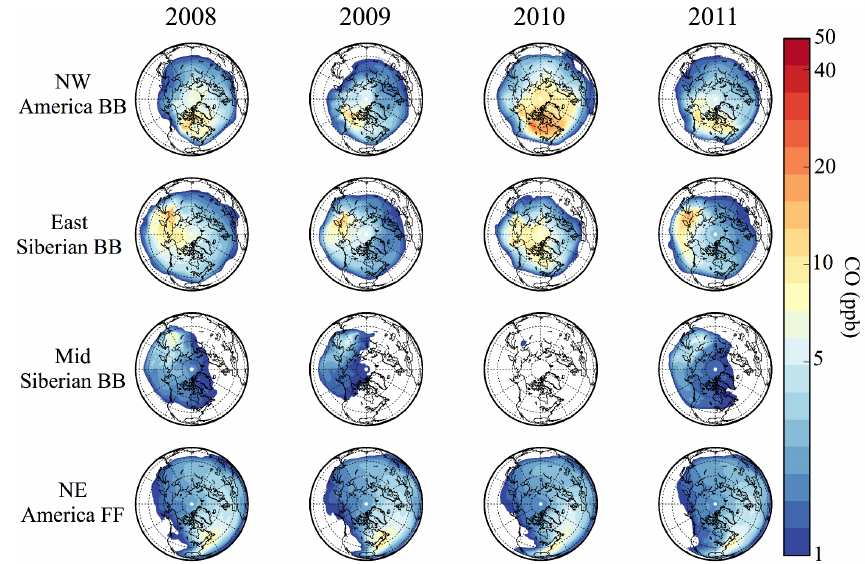
Figure 5. Same as Fig. 4 but at 4km altitude. Note the different upper limit to the colour bar.